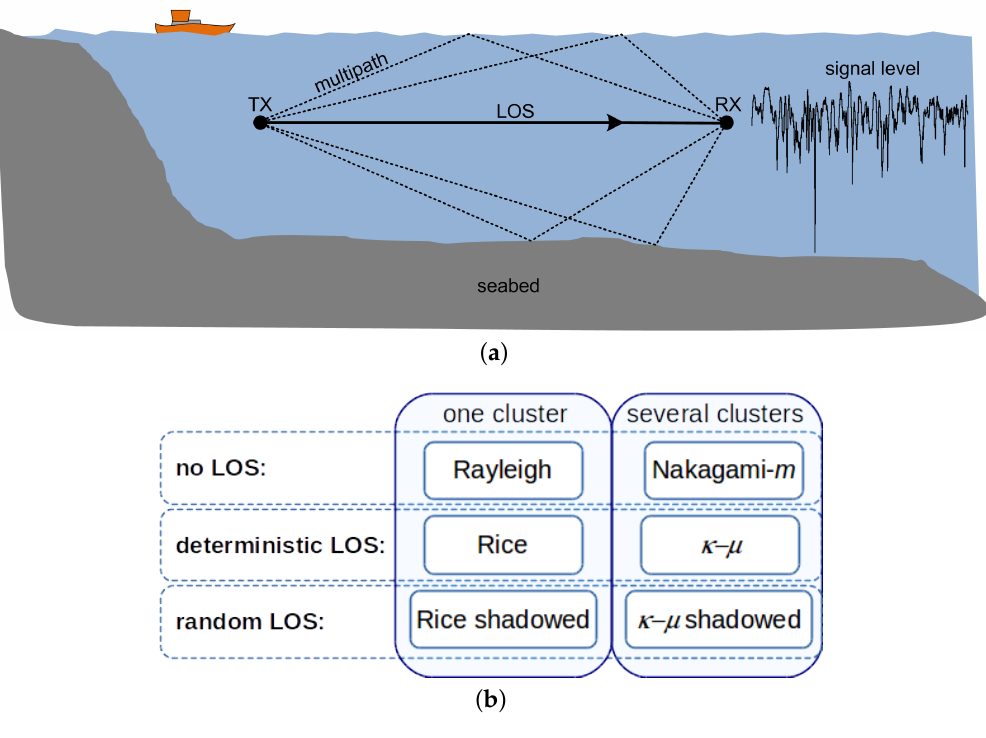
Figure 1. Channel modeling diagrams: ( a ) example of underwater acoustic communications system; ( b ) classification of fading